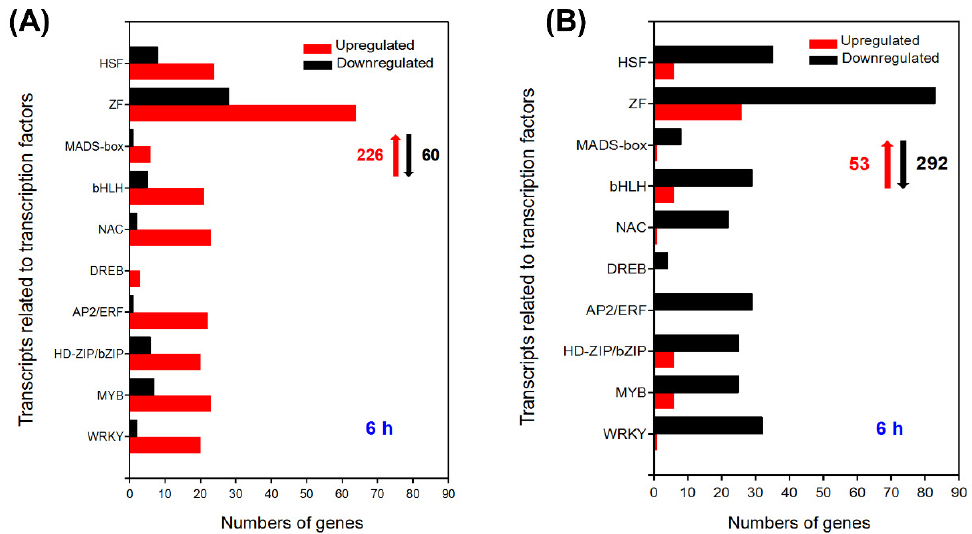
Figure 6. Number of DEGs related to transcription factors under 100 mM NaCl treatment for 6 h in leaves and roots ( A , B , respectively) of A. canescens . HSF: heat shock transcription factor, ZF: zinc finger, bHLH: basic helix-loop-helix, NAC: no apical meristem/Arabidopsis transcription activation factor/cup-shaped cotyledon, DREB: dehydration responsive element binding protein, AP2/ERF: APETALA2 and ethylene-responsive element binding proteins, bZIP: basic region-leucine zip-per/homeodomain-leucine zipper, MYB: myeloblastosis, WRKY: WRKY-domain protein. The red upward arrows and black downward arrows show the total number of upregulated DEGs and downregulated DEGs, respectively.